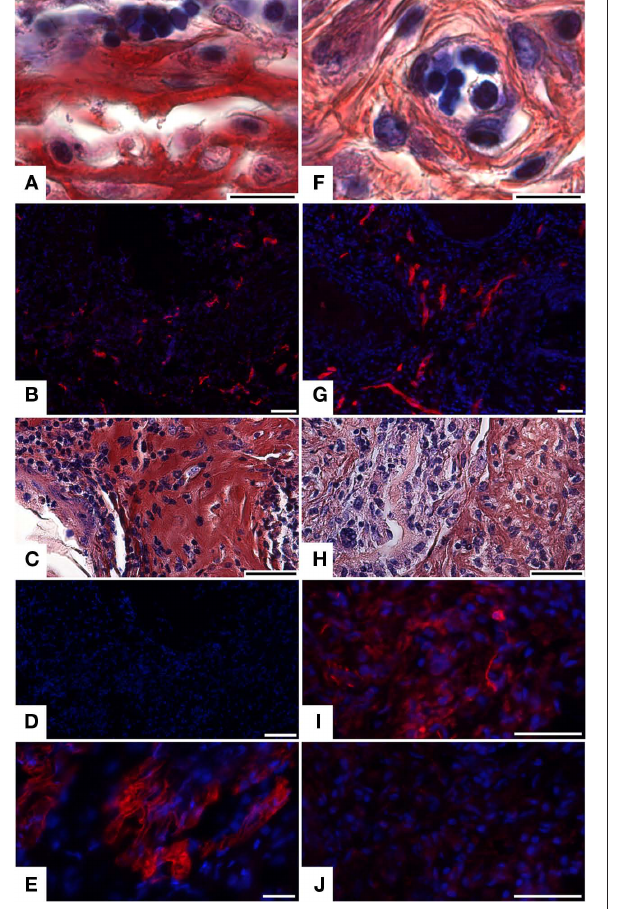
FiGuRe 2 | implantation of cultured re-associations between clonal dental mesenchymal cell lines and intact eD14 dental epithelium. After 2 days in vitro , re-associations performed with 17IA4 (A–e) and 705IC5 (F–J) clonal cell lines were implanted under the skin of a mouse for 2 weeks. Histology showed the presence of blood vessels in the two types of implants (A,F) , which was confirmed by immunostaining for CD31 (B,G) . Histological sections suggested differences in the extracellular matrix secreted by the two cell lines (C,H) . Immunostainings for aggrecan (D,i) and for osteopontin (e,J) showed differential antigenicity, in the matrix secreted by 17IA4 (C–e) and by 705IC5 (H–J) . Bars = 10 μm (A,F) , = 20 μm (e) , = 40 μm (C,G–J) , = 80 μm (B) , = 100 μm (D)